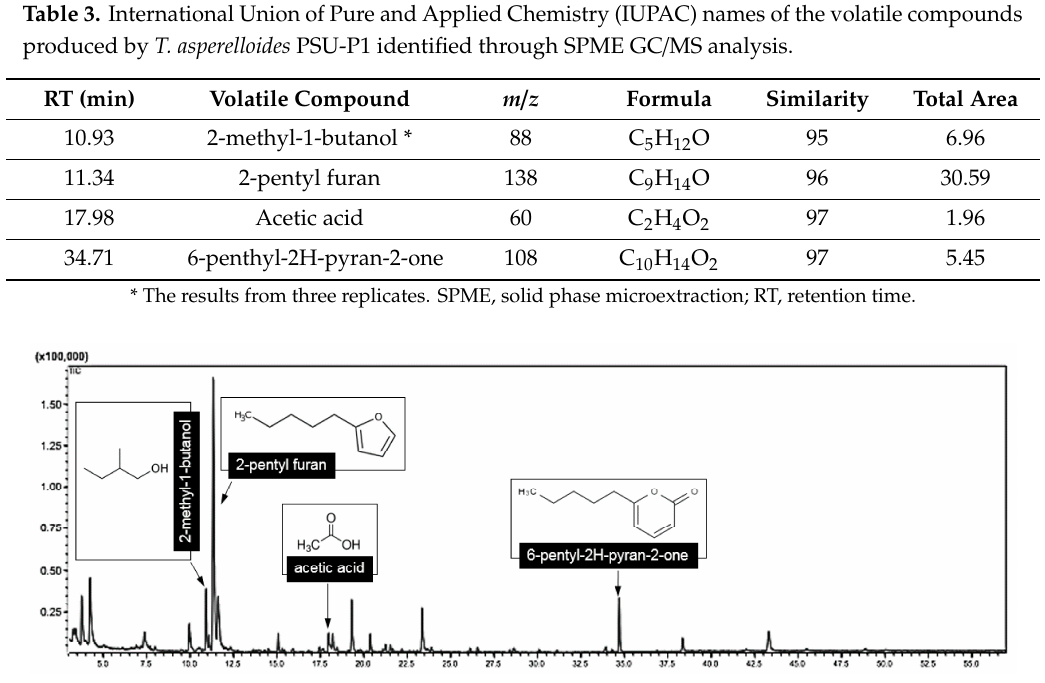
Figure 7. A chromatogram of the VOCs emitted by T. asperelloides PSU-P1 analyzed through SPME GC / MS.